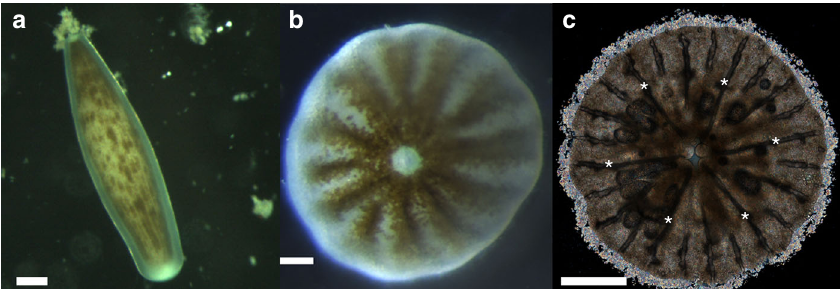
Fig. 1 Light microscopy images of Stylophora pistillata larvae. a The pre-settled, elongated, planktonic larva (side view). b A globe-shape mature planula at the pre-settled metamorphosed stage. The brown features are attributed to endosymbiont algae. c The primary settled polyp (bottom view). Under polarized light, the birefringent crystals formed on the circumference appear as bright spots, while the mineralized septa 9 , covered by organic layers of tissue, appear as the long dark streaks (the six primary septa are marked by asterisks), scale bars: a , c 500 µ m; b 200 µ m